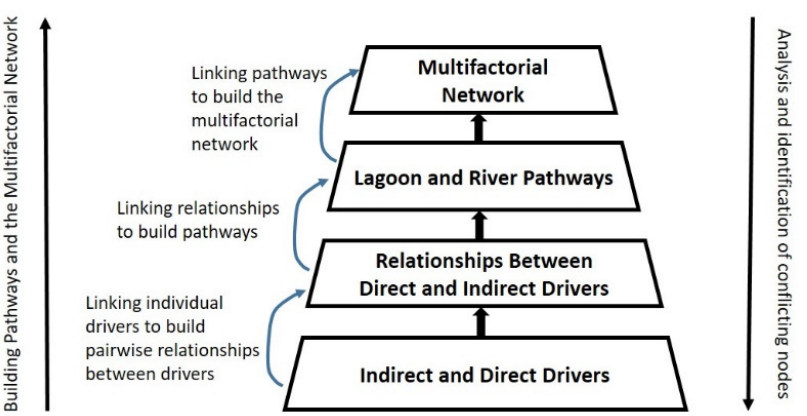
Figure 2. Bottom-up method for building pathways, and the top-down method to guide the analysis and identification of key nodes that may bring about temporal disorders.